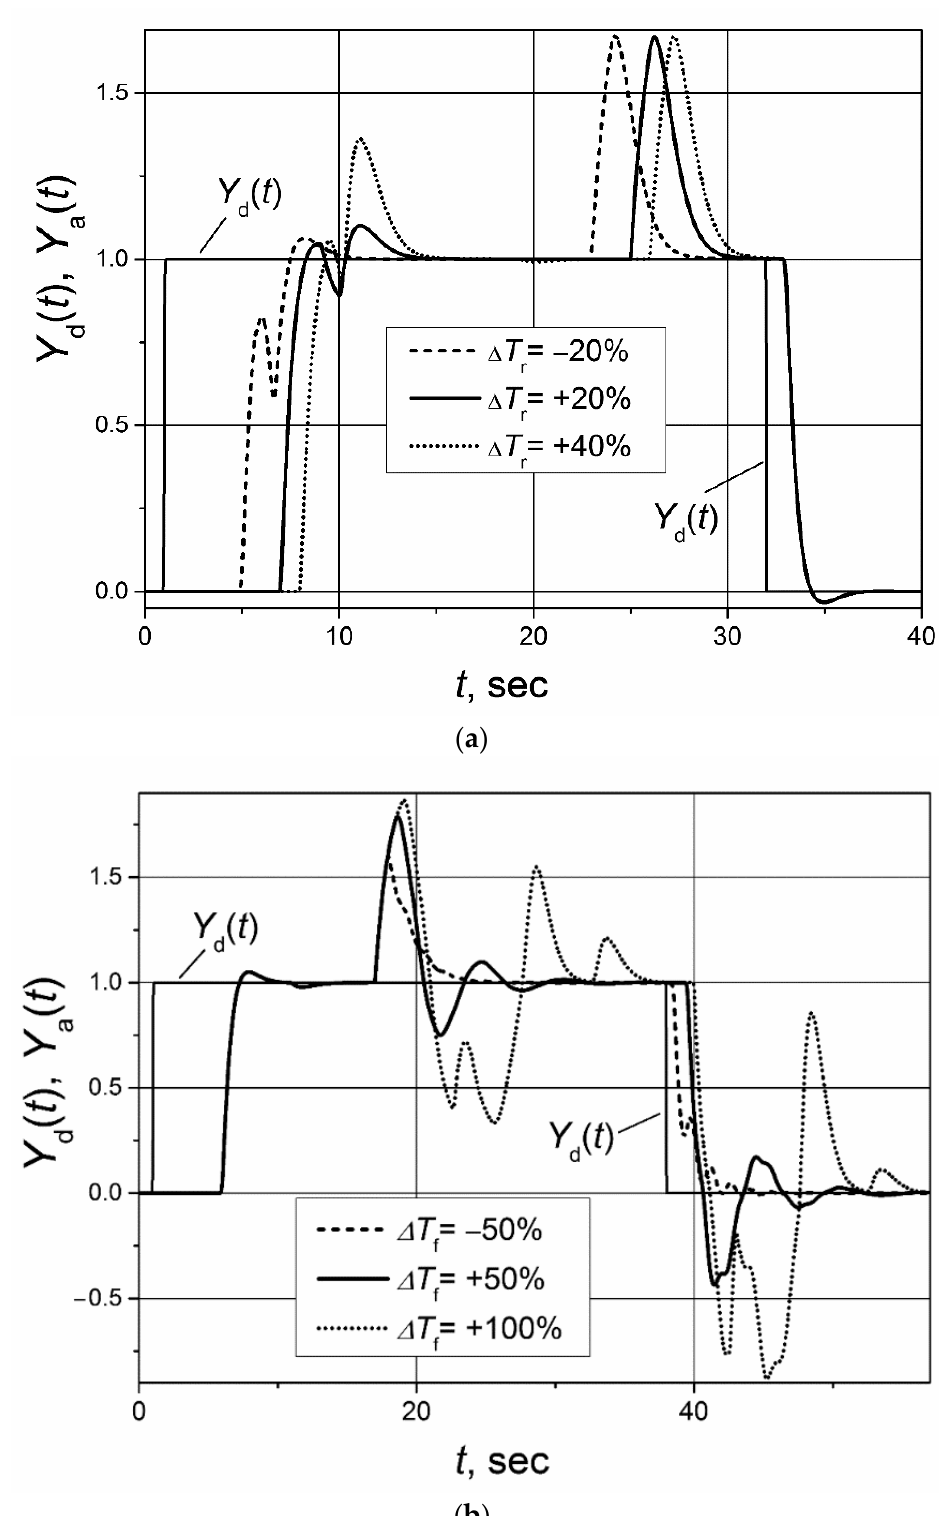
Figure 9. The set-point unit pulse and unit-load disturbance responses of the control system of the first-order plant with the asymmetric response delay based on the PI controller with the switched- delay Smith predictor when the plant-response delay changes: ( a ) changes just T r by value ∆ T r ; ( b ) changes just T f by value ∆ T f . Unit-load disturbances occur at times: t = 19 s ( a ); t = 12 s ( b ).